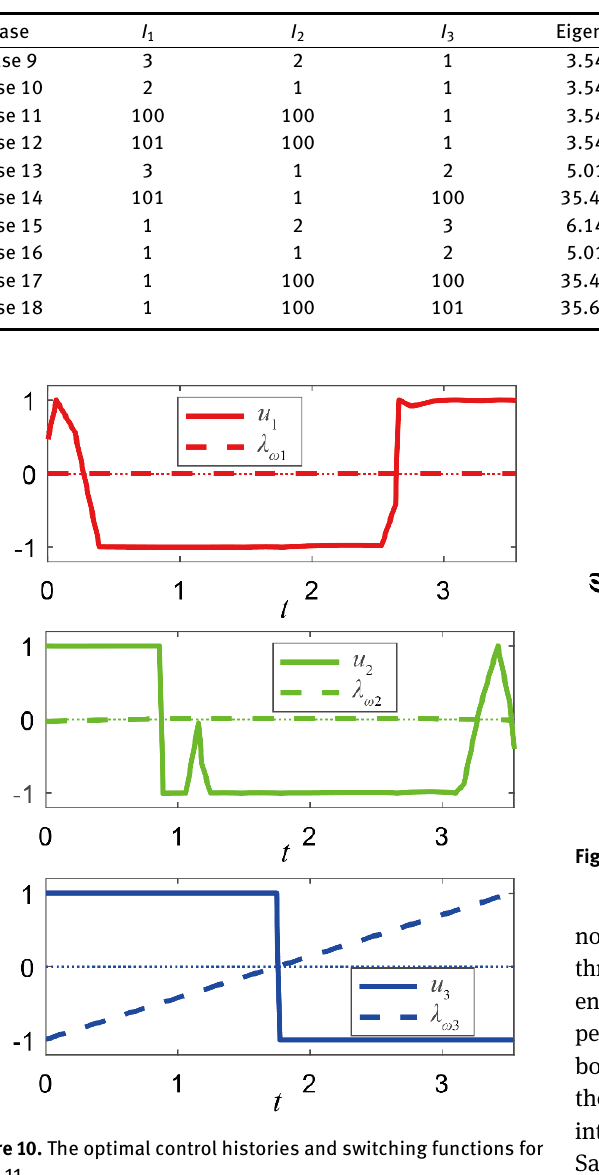
Table 3. The optimal solutions for some special cases